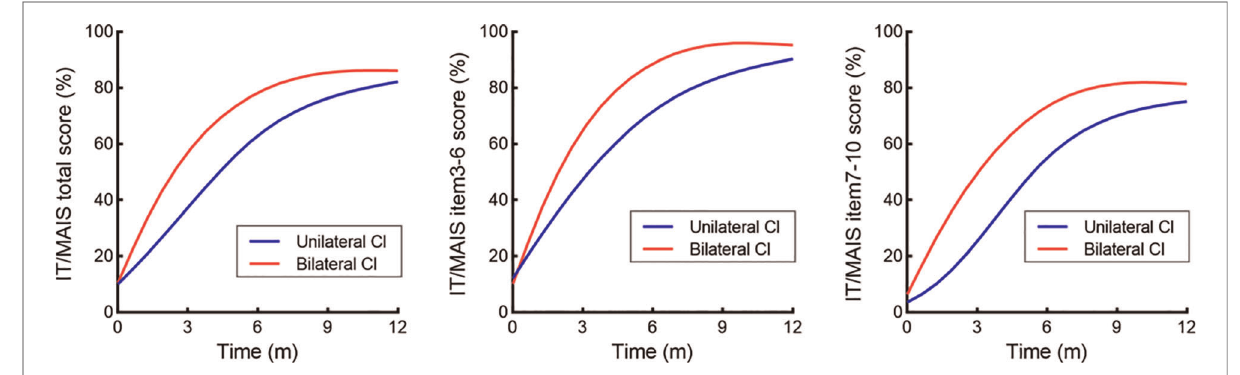
FIGURE 1 The trajectory of IT/MAIS scores using a third order